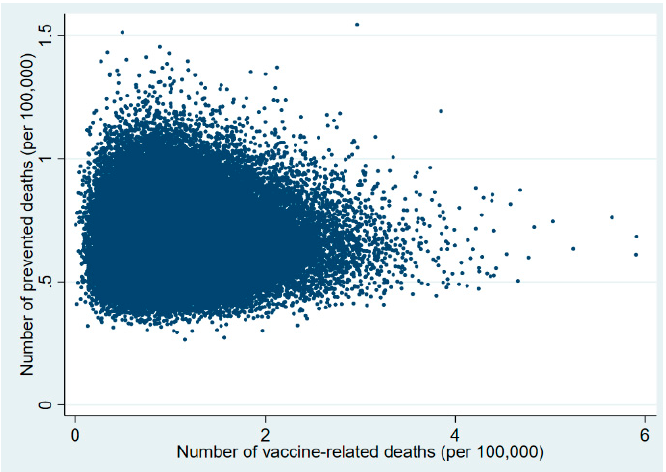
Figure 1. Probabilistic sensitivity analysis. Number of vaccine-prevented deaths for COVID-19 (benefit) vs. vaccine-related deaths for thrombo-embolic events (risk) after 100,000 simulations. Individuals aged 20–29 years, Italy.